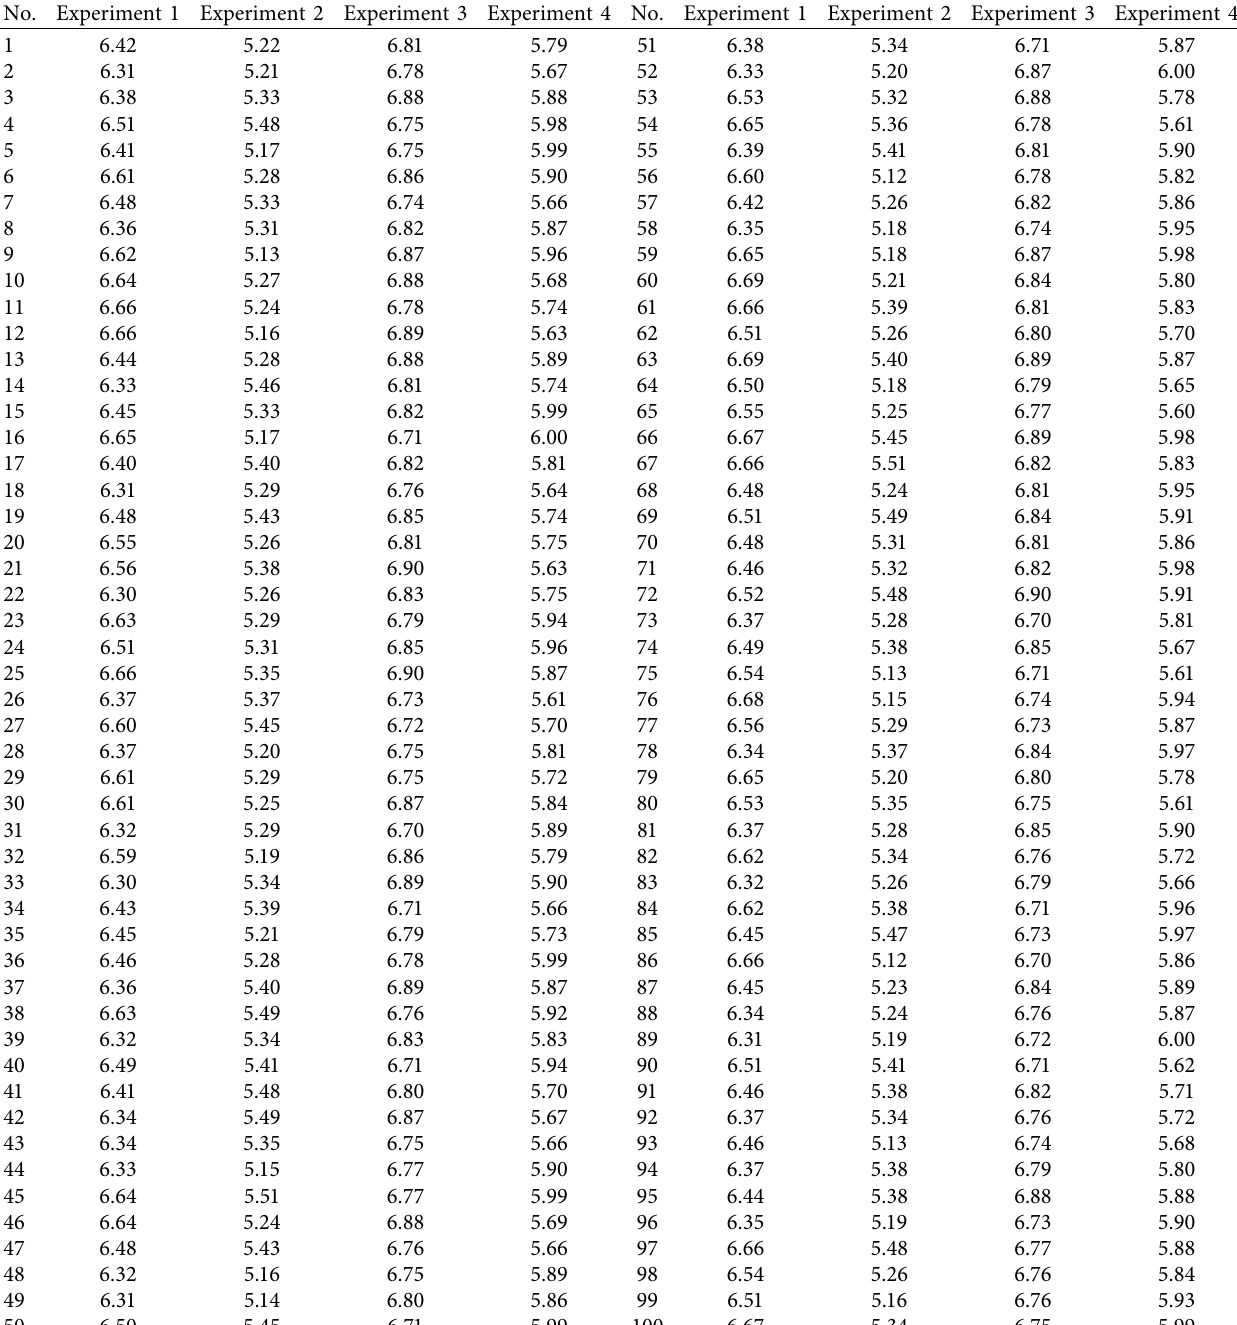
Table 2: Statistical table of processing speed in the frame selection partition fusion mode